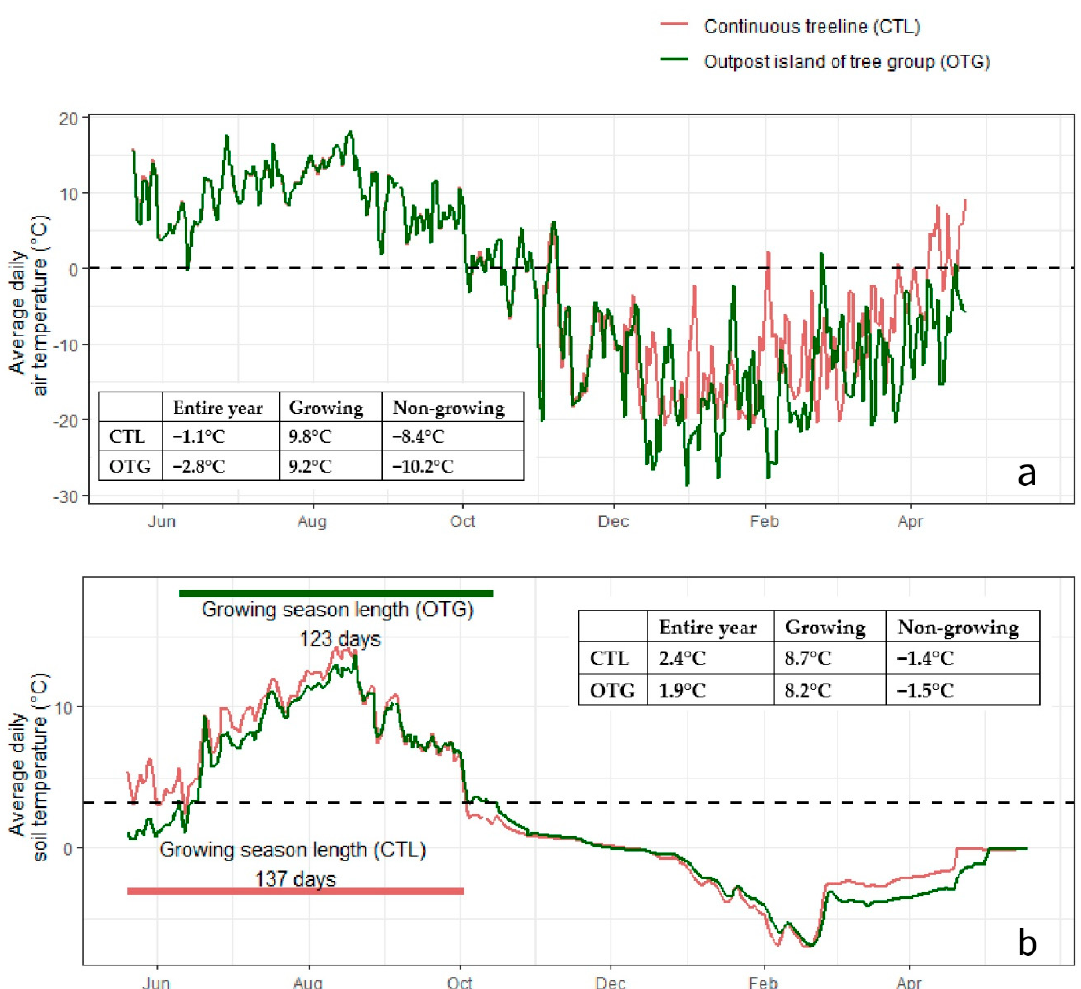
Figure 2. Average daily 2-m air temperature (a) and average daily 10-cm depth soil temperature (b) at continuous treeline site (CTL) and outpost-islands of tree group (OTG) on the north-facing slope of Changbai Mountain. Data was recorded from May 20, 2009 to May 20, 2010 (during the last 30 days, air temperature data was missing because of devices problem). The mean air or soil temperature in growing, non-growing, and the entire year was calculated and shown on the figure.